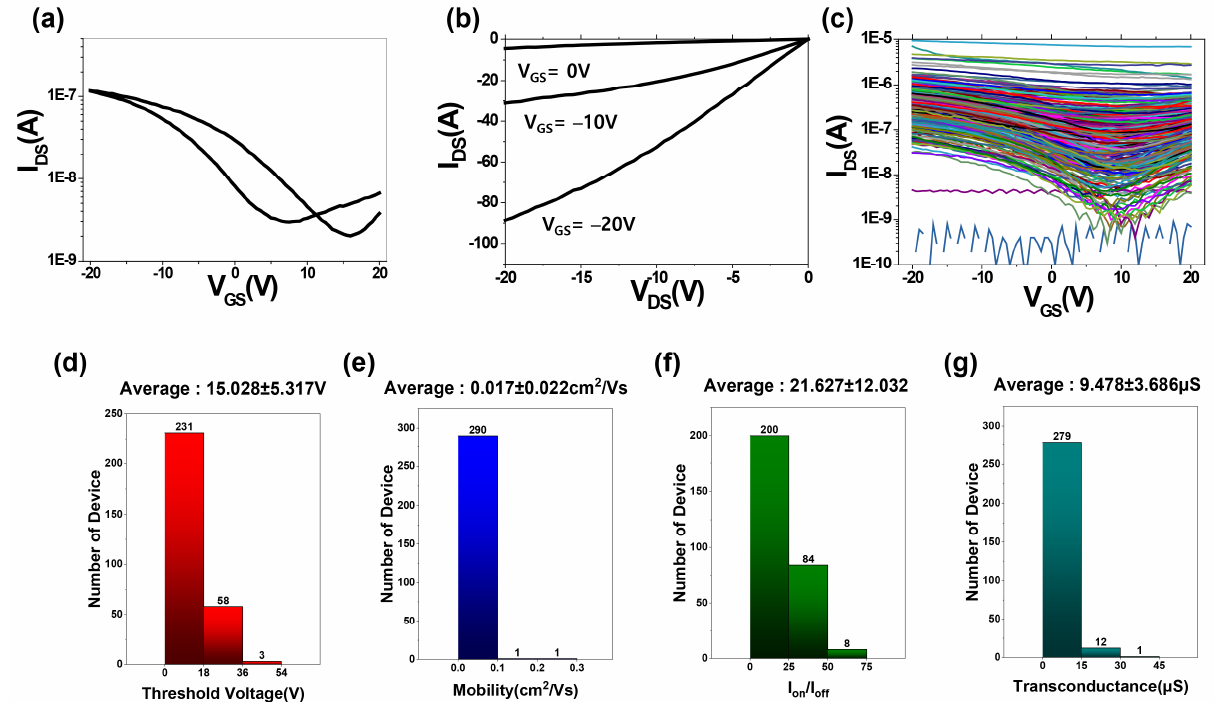
Figure 6. Typical characteristics of a single TFT from the 26 × 38 SWNCT-TFT array: ( a ) Transfer and ( b ) output characteristics of single SWCNT-TFT. ( c ) Overlayed transfer characteristics for all 26 × 38 SWNCT-TFTs in the array. ( d ) Calculated threshold voltage, ( e ) mobility, ( f ) on–off current ratio, and ( g ) transconductance of all 26 × 38 SWNCT-TFTs in the array.